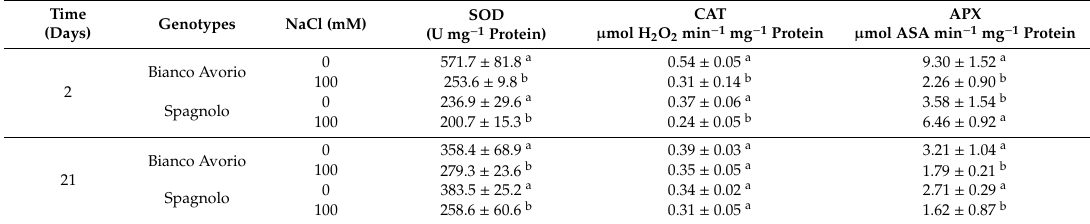
Each value represents the mean ± SD of three biological replicates. Values followed by di ff erent superscript letters are significantly di ff erent between genotypes and treatments within the same sampling time at p < 0.05, by analysis of variance (ANOVA).